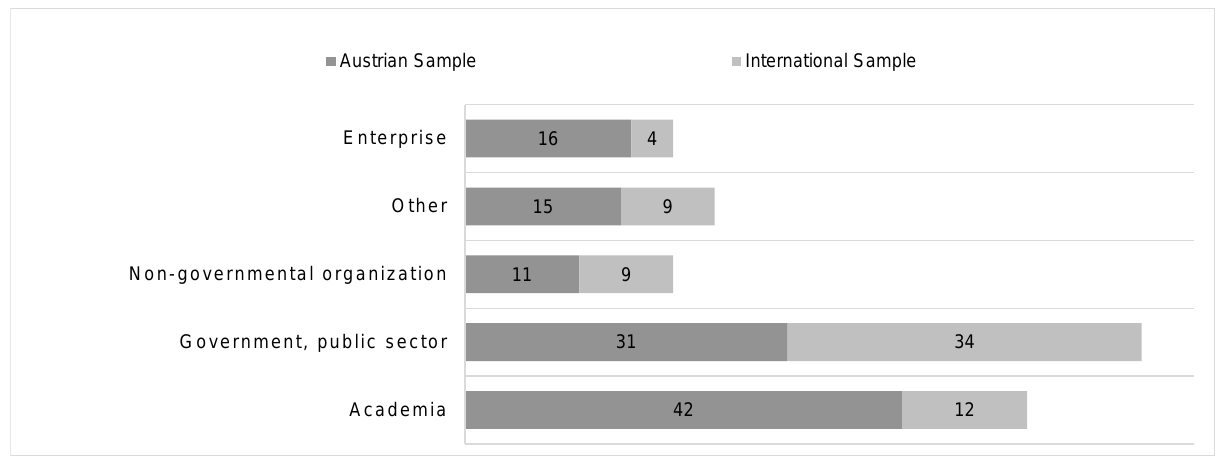
Figure 2: Types of Organizations in Austrian and International Sample (Source: Authors)